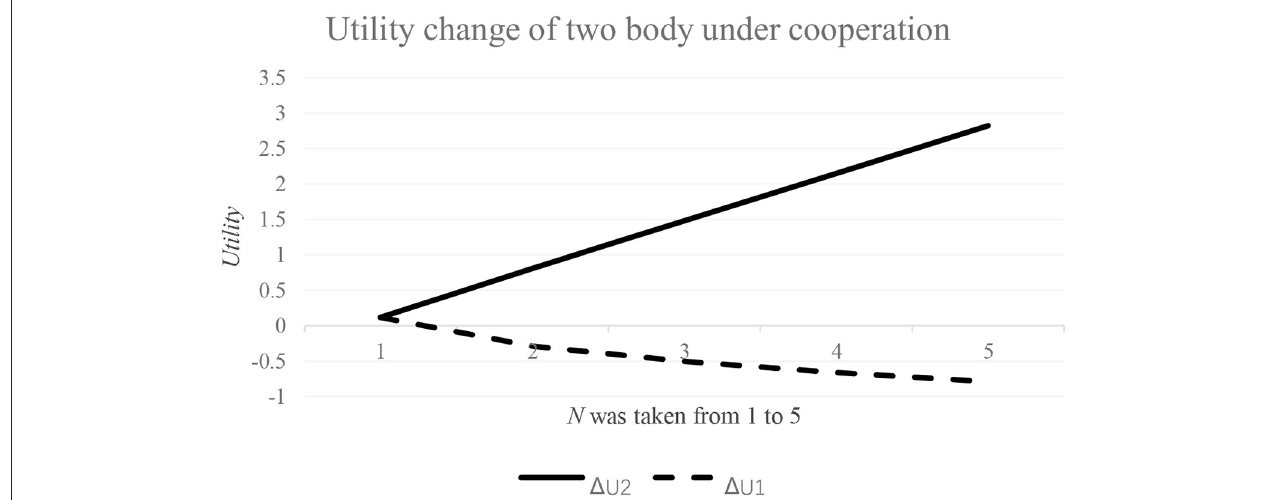
FIGURE 1 | Utility change of two countries in cooperation situation with different N .